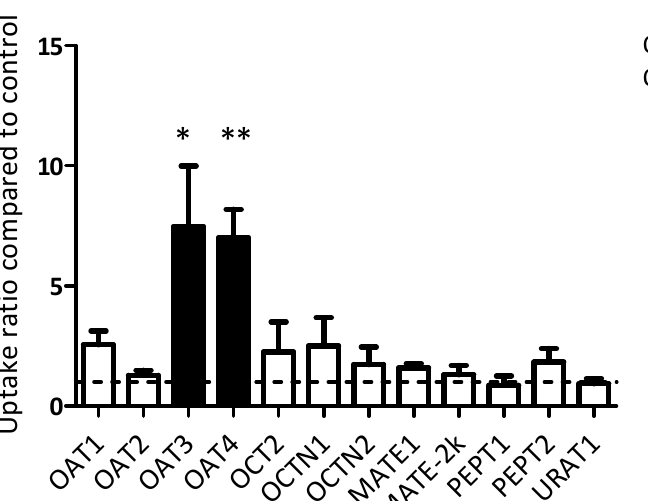
Figure 3. Uptake of enalaprilat was mediated by OAT3 and OAT4 in HEK293 cells transiently overexpressing a single uptake transporter. Transport is expressed as ratio of control cells and presented as means ± SEM. Data were pooled from three independent experiments. Dotted line represents a ratio between transporter and control of 1 (i.e., no active transport). An asterisk indicates a statistically significant difference from the control by one-way ANOVA using Dunnett’s post hoc test (* p < 0.05, ** p < 0.01).